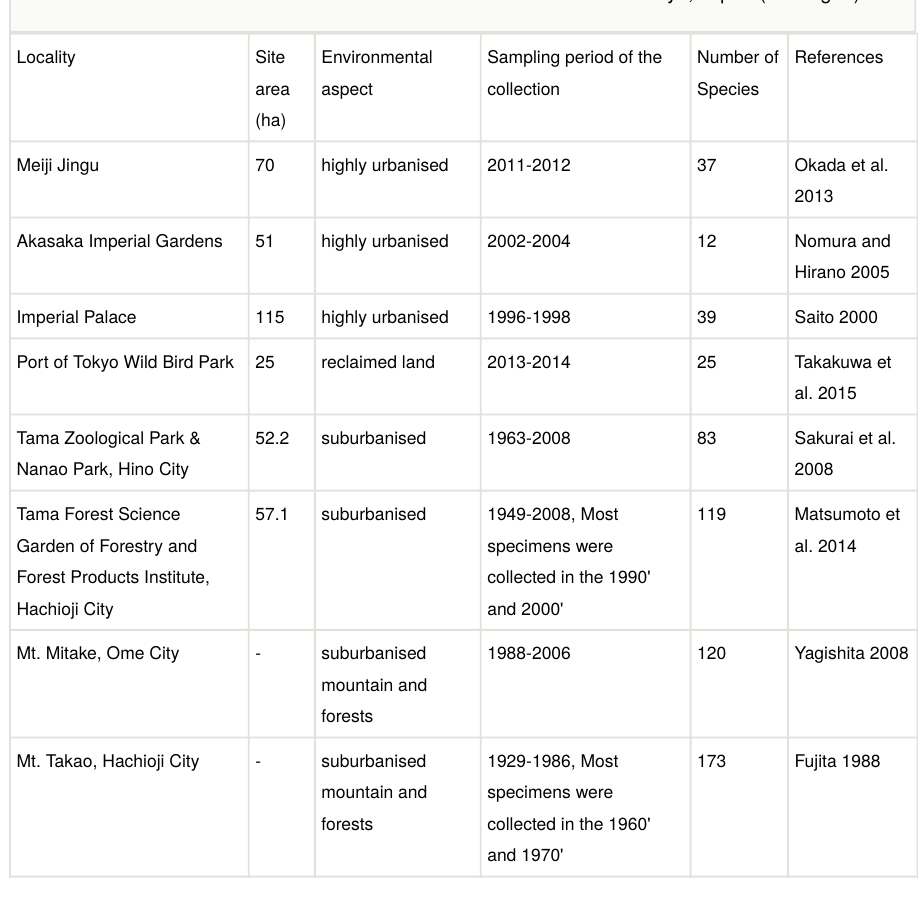
Table 1. Detailed characteristics of each reference site. All sites are located in Tokyo, Japan (see Fig.